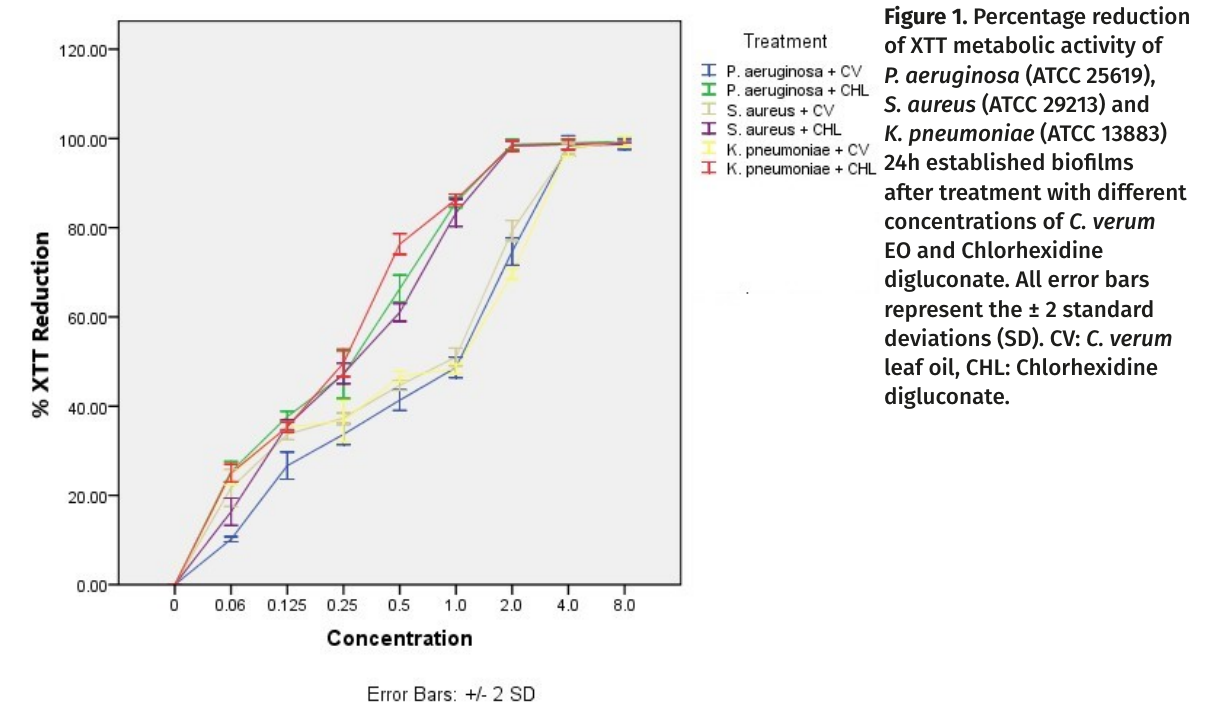
Figure 2. Log CFU values of 24h established P. aeruginosa (ATCC 25619), S. aureus (ATCC 29213) and K. pneumoniae (ATCC 13883) biofilms after the treatment with different concentrations of CV: C. verum leaf oil and CHL: Chlorhexidine digluconate. All error bars represent the ± 2 standard deviations